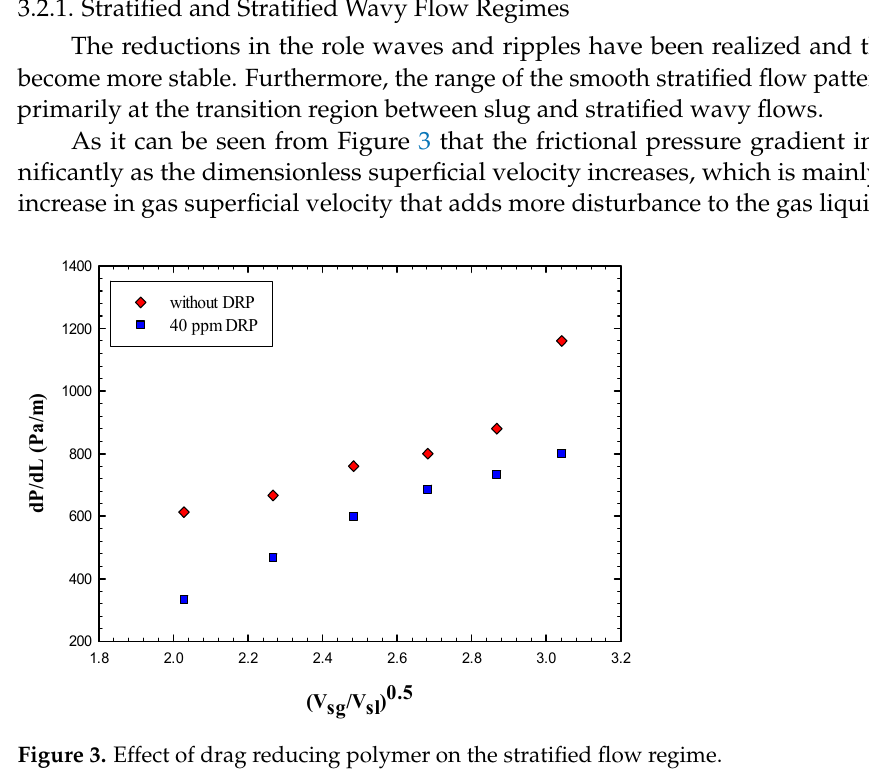
Figure 3. Effect of drag reducing polymer on the stratified flow regime.